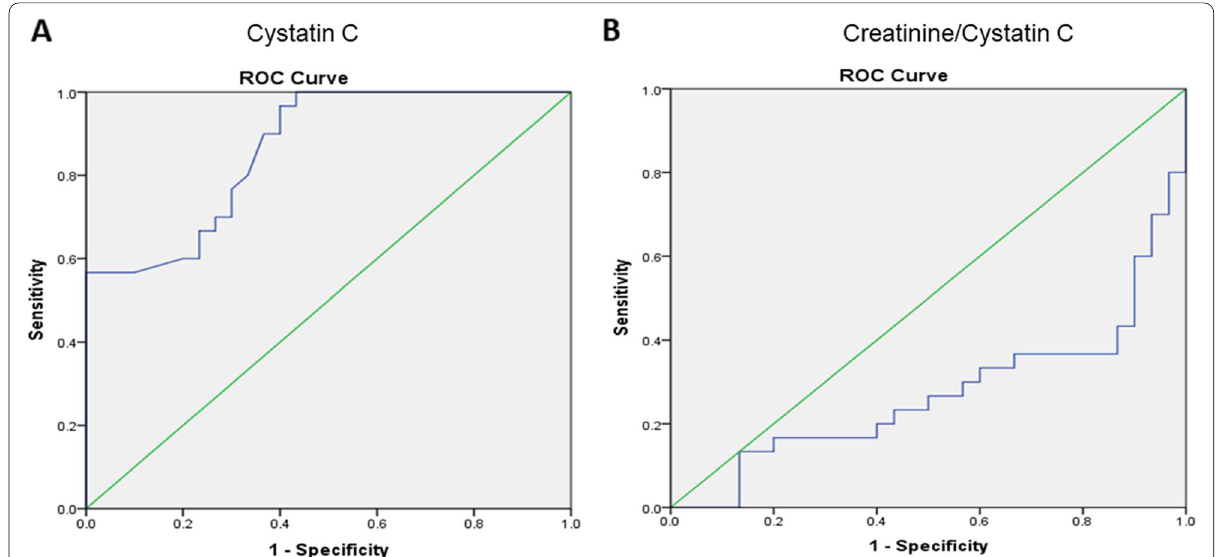
Fig. 1 ROC curves of cystatin C in HCV-infected patients ( A ). ROC curves of creatinine/cystatin C in HCV-infected patients ( B